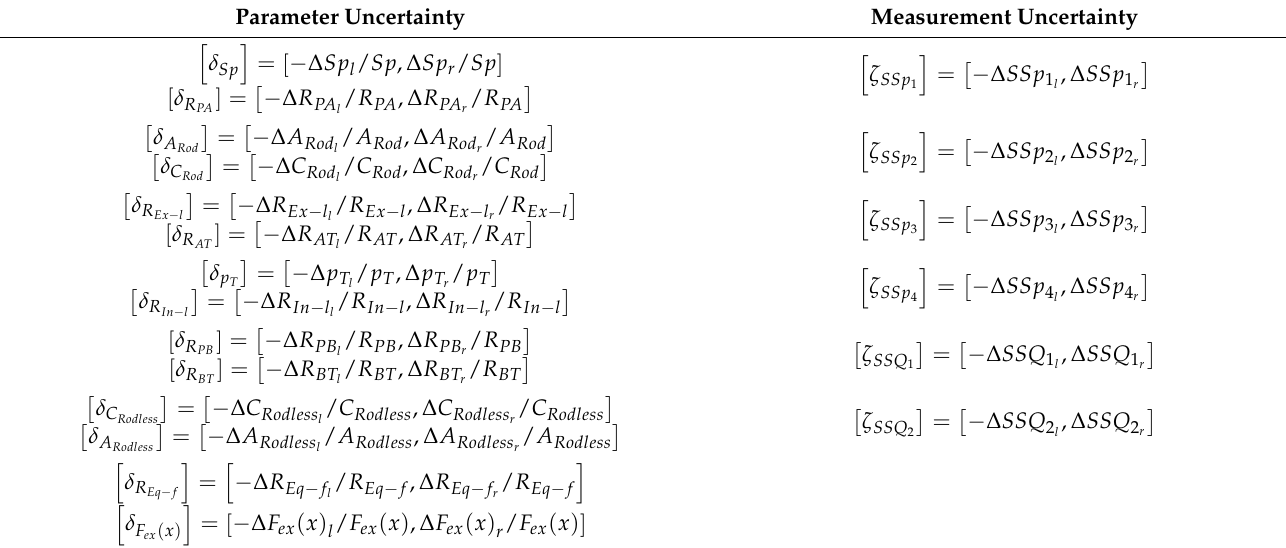
Table 5. Interval values in Equations (37) and (38). Parameter Uncertainty Measurement